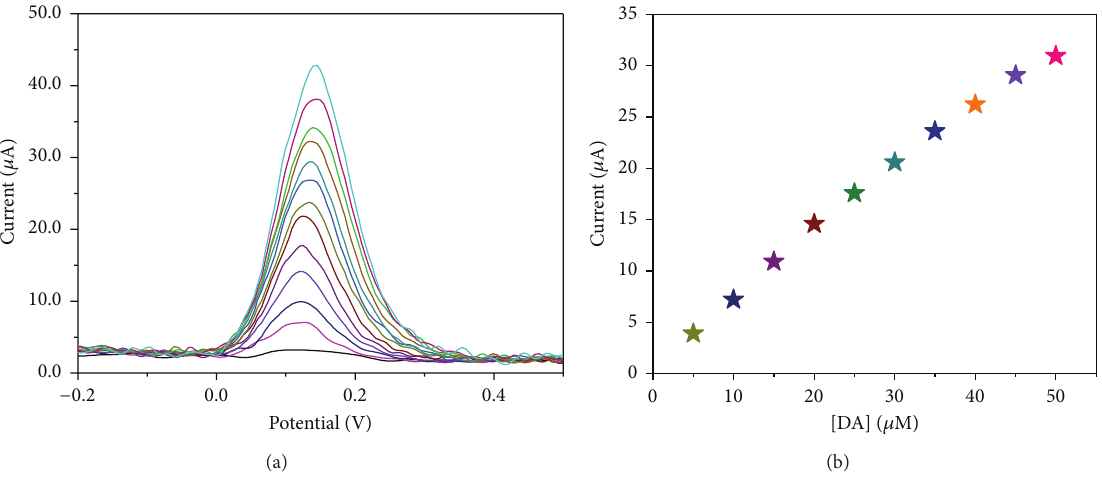
Figure 13: (a) Square wave voltammograms recorded for 𝛼 -Fe 2 O 3 nanoparticle-modified electrode during successive addition of 5 𝜇 M of DA in 0.1M PBS (pH = 6.8) at scan rate of 100mVs −1 . (b) The calibration curve obtained upon the 5 𝜇 M addition of DA in 0.1M PBS (pH =